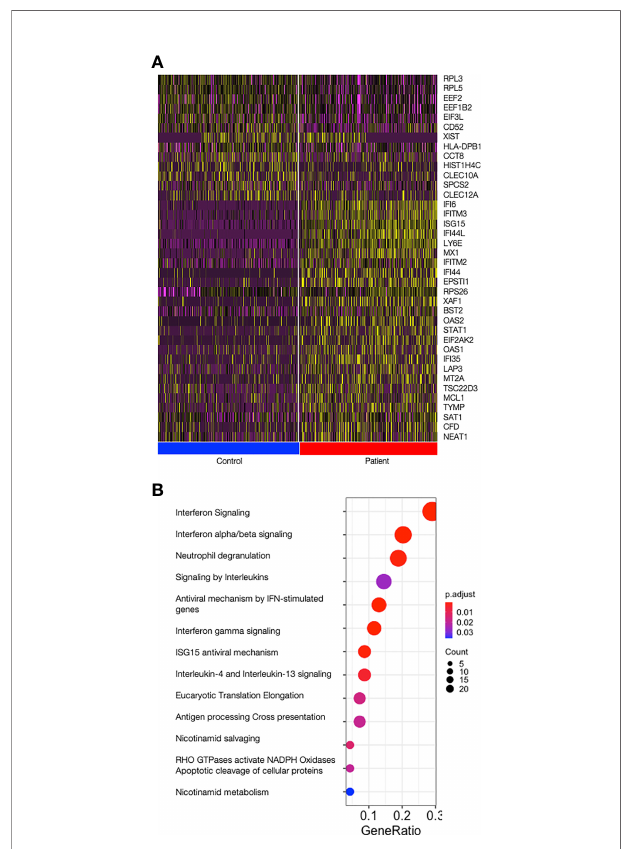
FIGURE 1 | Type I Interferon stimulatedgenes are upregulated inpatients. (A) Heat map showing the top25 most differentially expressed genes between patients and control cells over allcells analysed (allcelltypes joined); ontop, all13 genes upregulated incontrols andonthe bottom the top 25 genes upregulated in patients are shown. Control cells are shown on the left(blue bar)and patient ’ s cells are shown on the right (redbar). Graduation ofexpression ranges from purple(absent) to yellow (high). (B) Dotplot showing signi fi cance of the pathways enriched in patients (ReactomePA). Count isthe number of genes involvedin the pathway. Gene Ratiois the ratioof the genes involved ineach pathway to the totalnumber of cluster genes. P adjust isthe adjusted